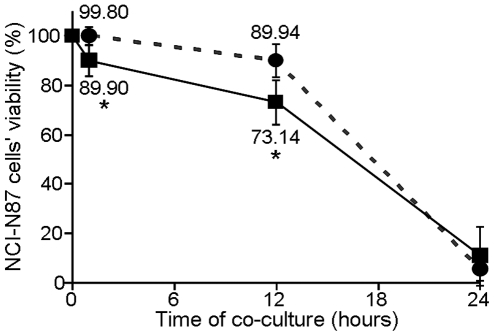
Impact of the two isogenic groups of pediatric H. pylori strains on NCI-N87 cells viability.The viability of NCI-N87 cells was assessed by the trypan blue exclusion assay after 1, 12 and 24 h of co-culture with a pool of five pediatric PUD-associated strains (▪ in full line) and a pool of five pediatric NUD-associated strains (• in dashed line). For normalization, the value of 100% corresponds to the viability of non-infected NCI-N87 cells. * indicates values that were determined as significantly different (p<0.05) between the viability of cells infected with PUD strains and that of cells infected with NUD-strains at the same time-point of co-culture. Symbols and error bars are means ± SD of the values at each point for 3 observations.